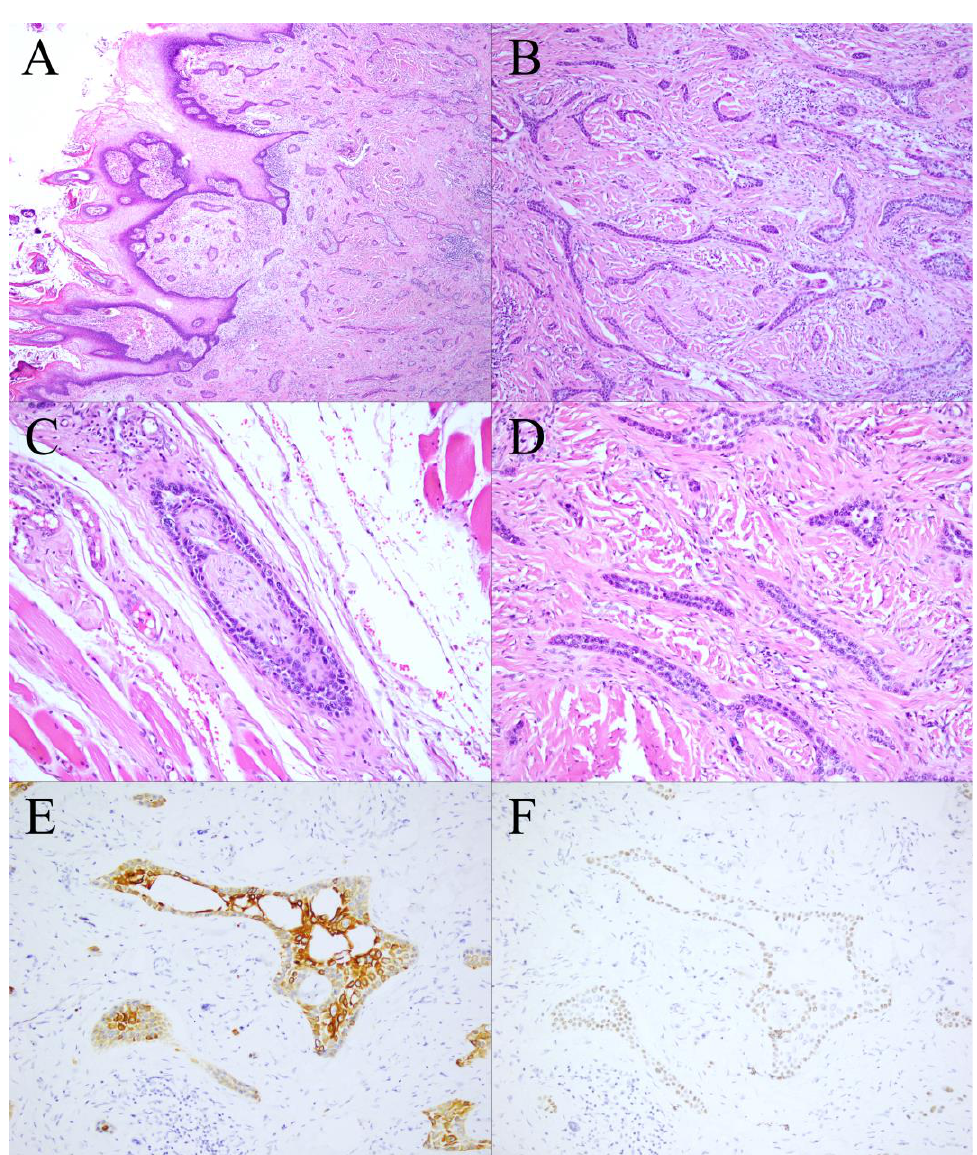
Figure 2. The tumor exhibited diffusely infiltrating cords, tubules, and strands of epithelial cells without overlying mucosal dysplasia (( A , B ), ×40). Higher magnification showed wide infiltration into adjacent skeletal muscle and perineural invasion (( C ), ×200). Bilayer cell structures with a relatively bland appearance were noted (( D ), ×200). In immunohistochemistry, CK7 and p40 highlighted a dual cell population of luminal and abluminal cells (( E ): CK7, ×200; ( F ): p40, ×200).